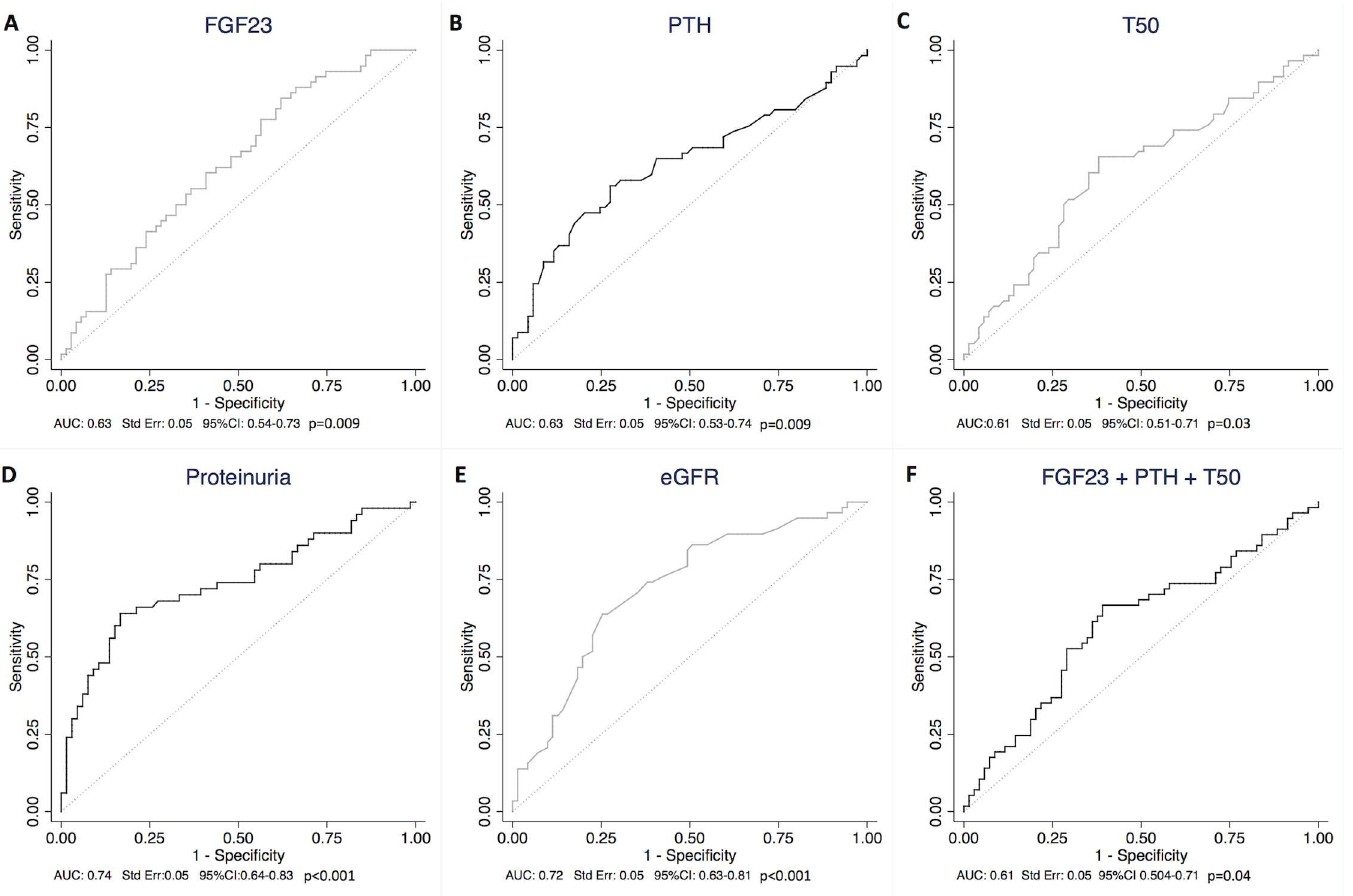
Fig 2. ROC curves of ln FGF23, ln PTH, T 50 , proteinuria and eGFR in predicting fibrosis (cid:20) 20%. ROC curve analysisof ln FGF23 (Fig 2A), ln PTH (Fig 2B), T 50 (Fig 2C), proteinuria(Fig 2D), eGFR (Fig 2E) for the prediction of fibrosis (cid:20) 20%. (2F): ROC cuvre analysisof ln FGF23, ln PTH and T 50 combinedfor the prediction of fibrosis (cid:20) 20%. As T 50 and eGFR are markers that are negatively associatedwith fibrosis, we used the oppositevalues of those markers. AUC: Area Under the Curve; eGFR: estimated GlomerularFiltration Rate; FGF23: Fibroblast growth factor 23; Ln: log-transformed; PTH: parathyroid hormone; ROC: ReceiverOperatingCharacteristic; T 50 : Calcificationpropensity.